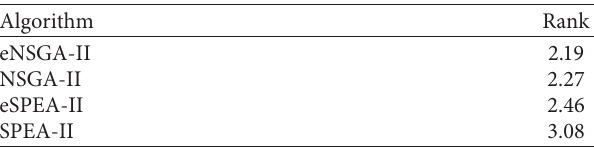
Table 6: Friedman test ranking for eNSGA-II, eSPEA-II, NSGA-II, and SPEA-II algorithms using the